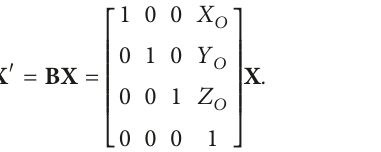
Figure 4: 2D random aggregate model of crushed stone concrete. (a) r r min � 0.475, r max � 4, Q s � 30%, n � 4–10, α 1 � 200 ° , α 2 � 20 ° ; (c) r min � 0.475, r max � 4, Q s � 30%, n � 4–10, α 1 � 200 ° , α 2 � 25 °